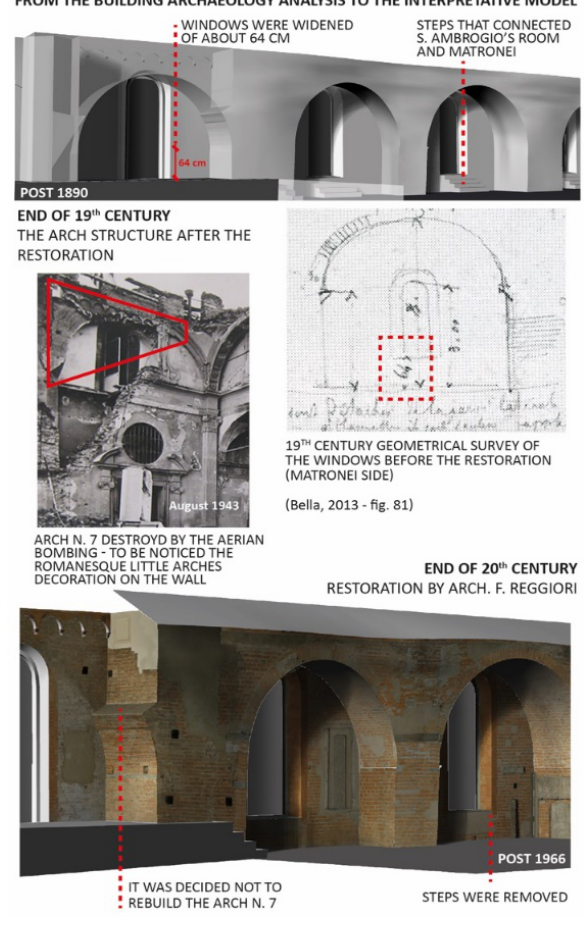
Figure 9. Single-lancet windows construction